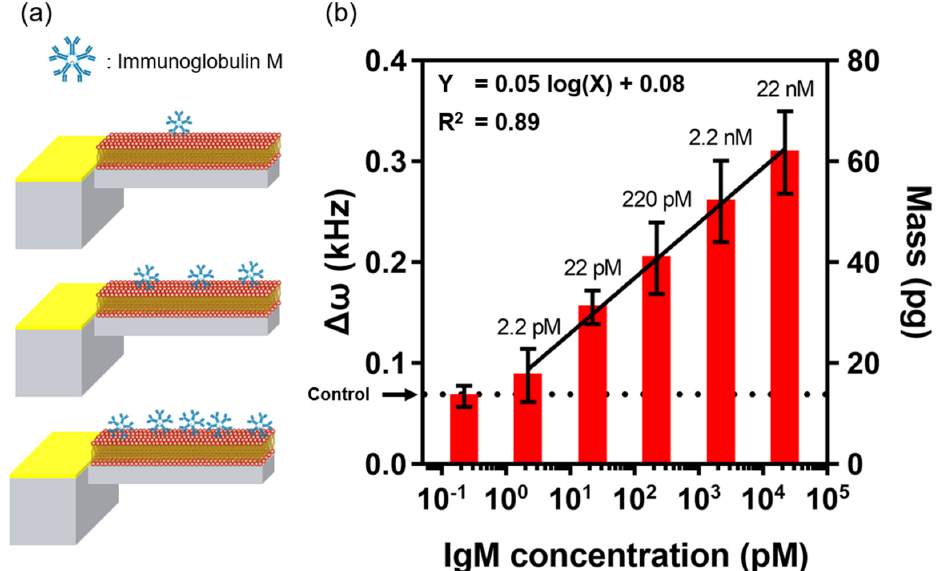
Figure 4. ( a ) Schematic illustration of IgM assay using the EMMC. ( b ) ∆ ω and mass of EMMC as a function of IgM concentration. The dotted line indicates the value of ∆ ω and mass of the control experiment. For each IgM concentration, a triplicate measurement was performed.